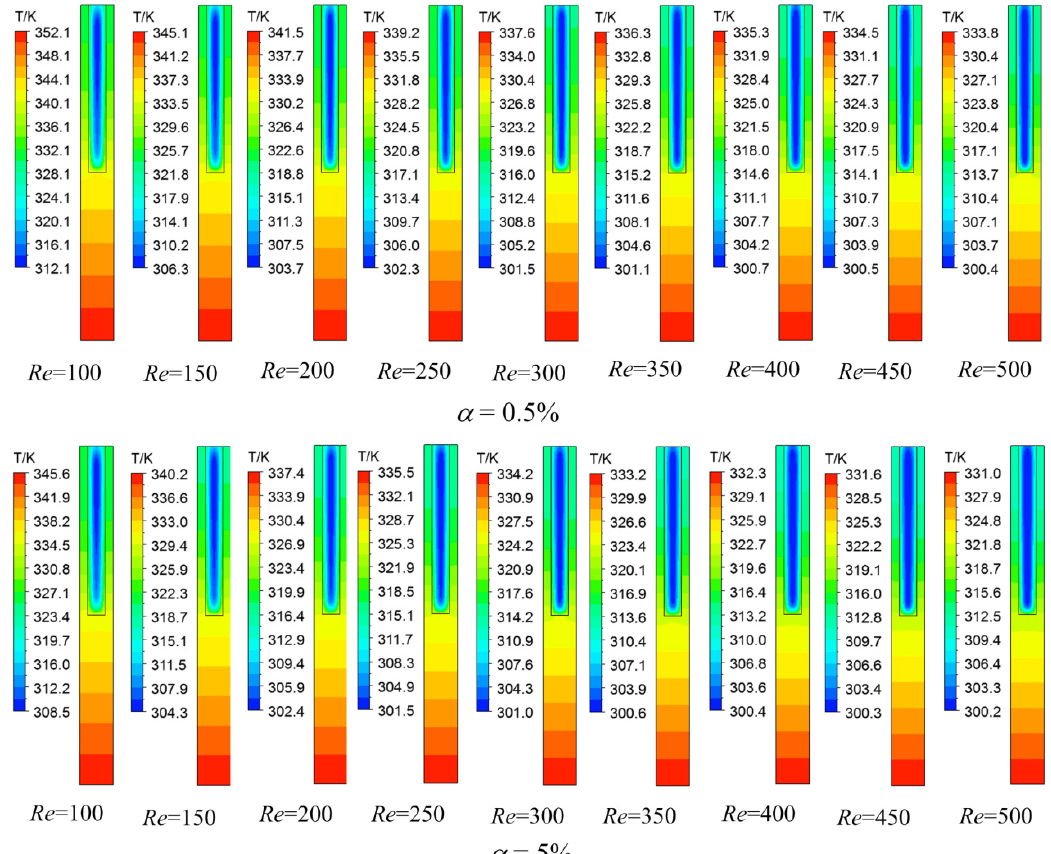
Figure 3. Temperature distributions of fluid and solid domains at the middle plane. The average temperature on the heat exchange surface of the fluid and solid domains under each working condition is obtained. The results are shown in Figure 4. With the increase of the Reynolds number, the average temperature on the heat transfer surface of the two types of nanofluids decreases. At the same Reynolds number, increasing the volume fraction of nanoparticles in the nanofluid can reduce the temperature on the heat transfer surface. In the range of Reynolds numbers studied in this work, the average temperature difference on the heat transfer surface caused by the differences in nanoparticle volume fraction decreases with the increase of the Reynolds number. When the Re is 100, the average temperature difference between the nanofluid with a nanoparticle volume fraction of 5% and that with a nanoparticle volume fraction of 0.5% is 6.3 K. When the Re is 500, the average temperature difference of the heat exchange surface decreases to 2.6 K. This result shows that the average temperature of the heat exchange surface can be reduced by increasing the nanoparticle volume fraction under the condition with a low Reynolds